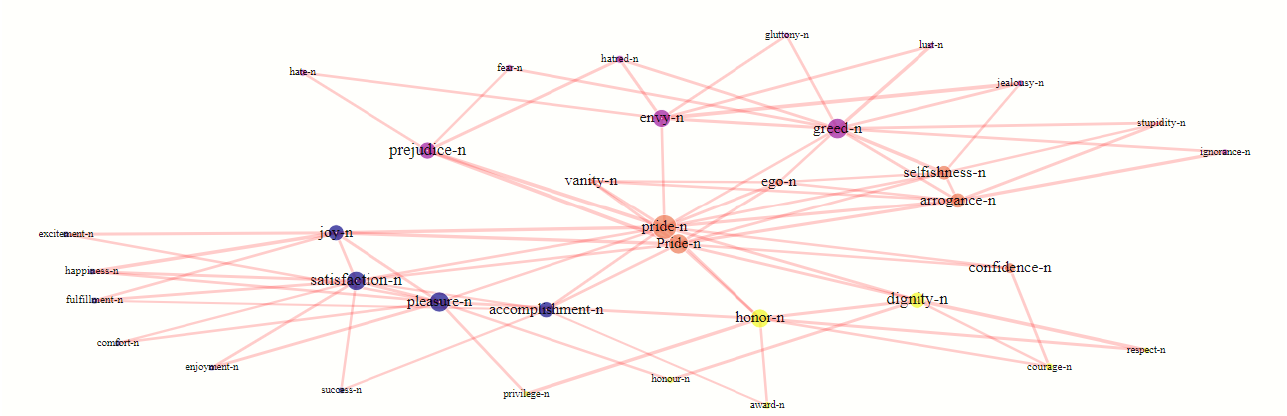
Figure 3. Representation of a second order clustered coordination based lexical graph of a seed lexeme pride-n pruned with degree ≥ 2: 35 nodes, 84 edges, 4 clusters; parameters: corpus = ententen13, n = 15, clustering = leiden , partition = mvp . Table 1. Labels of communities in lexical dependency graph of lexeme pride-n calculated on ententen13 corpus.